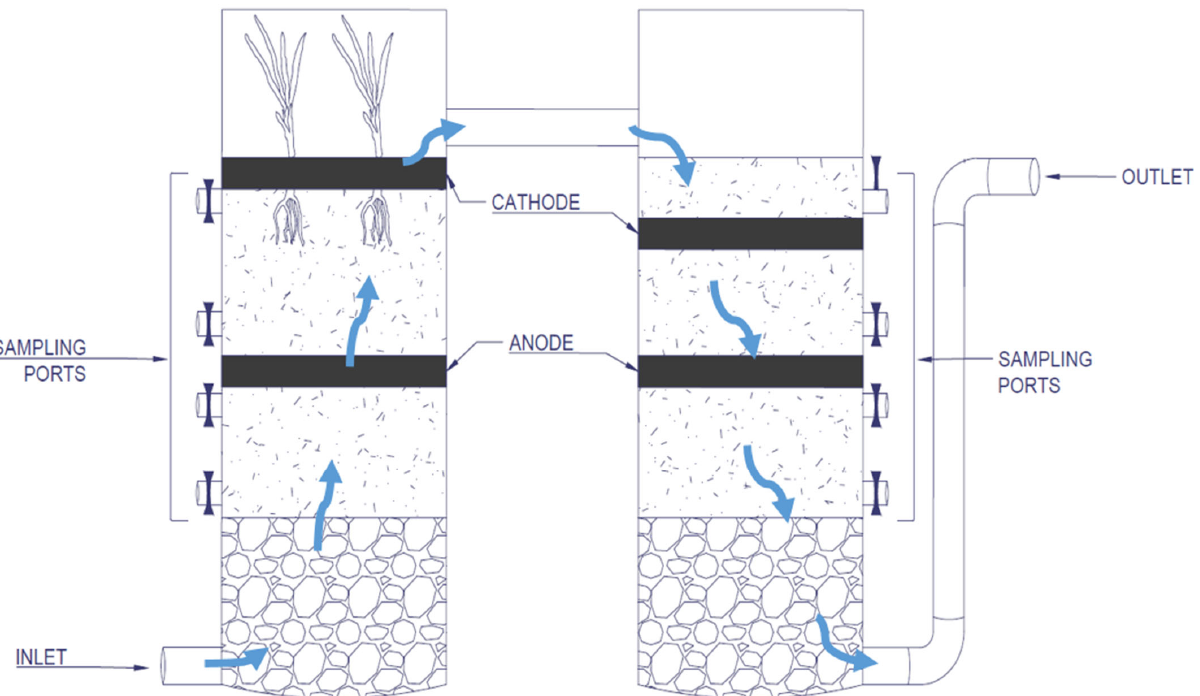
Figure 11. Integrated vertical-flow CW-MFC system with up-flow ( right ) and down-flow ( left ) chambers ( adapted from Zhong et al. (2020) [17]).